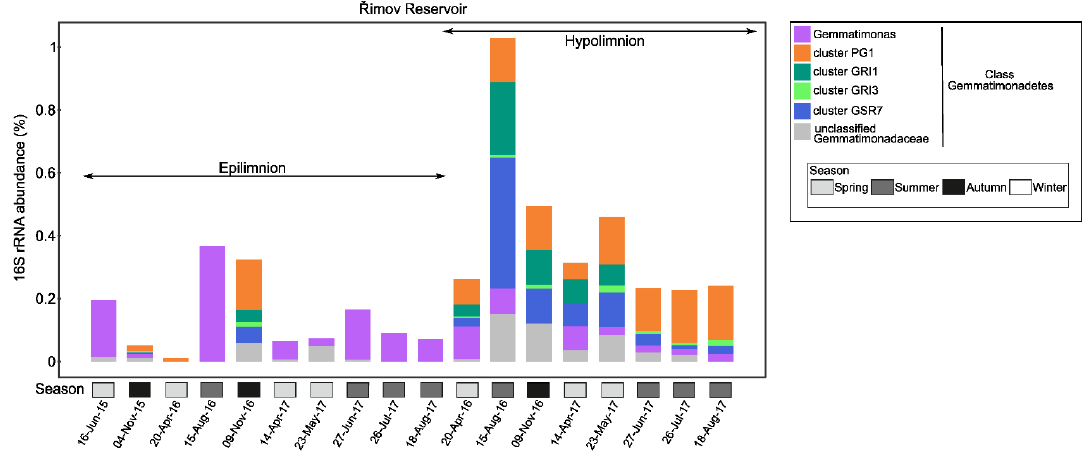
Figure 7. The relative abundances of 16S rRNA gene of Gemmatimonadota from metagenomes of a freshwater Ř ímov Reservoir in the Czech Republic. Only the class Gemmatimonadetes is represented in Ř ímov Reservoir, and newly defined clusters are shown (legend on the right). On the X-axis are shown sample dates and the season (gray-colored boxes), and on the Y-axis is shown the percentage of Gemmatimonadota in the prokaryotic community. The figure was adapted from ref. [18].